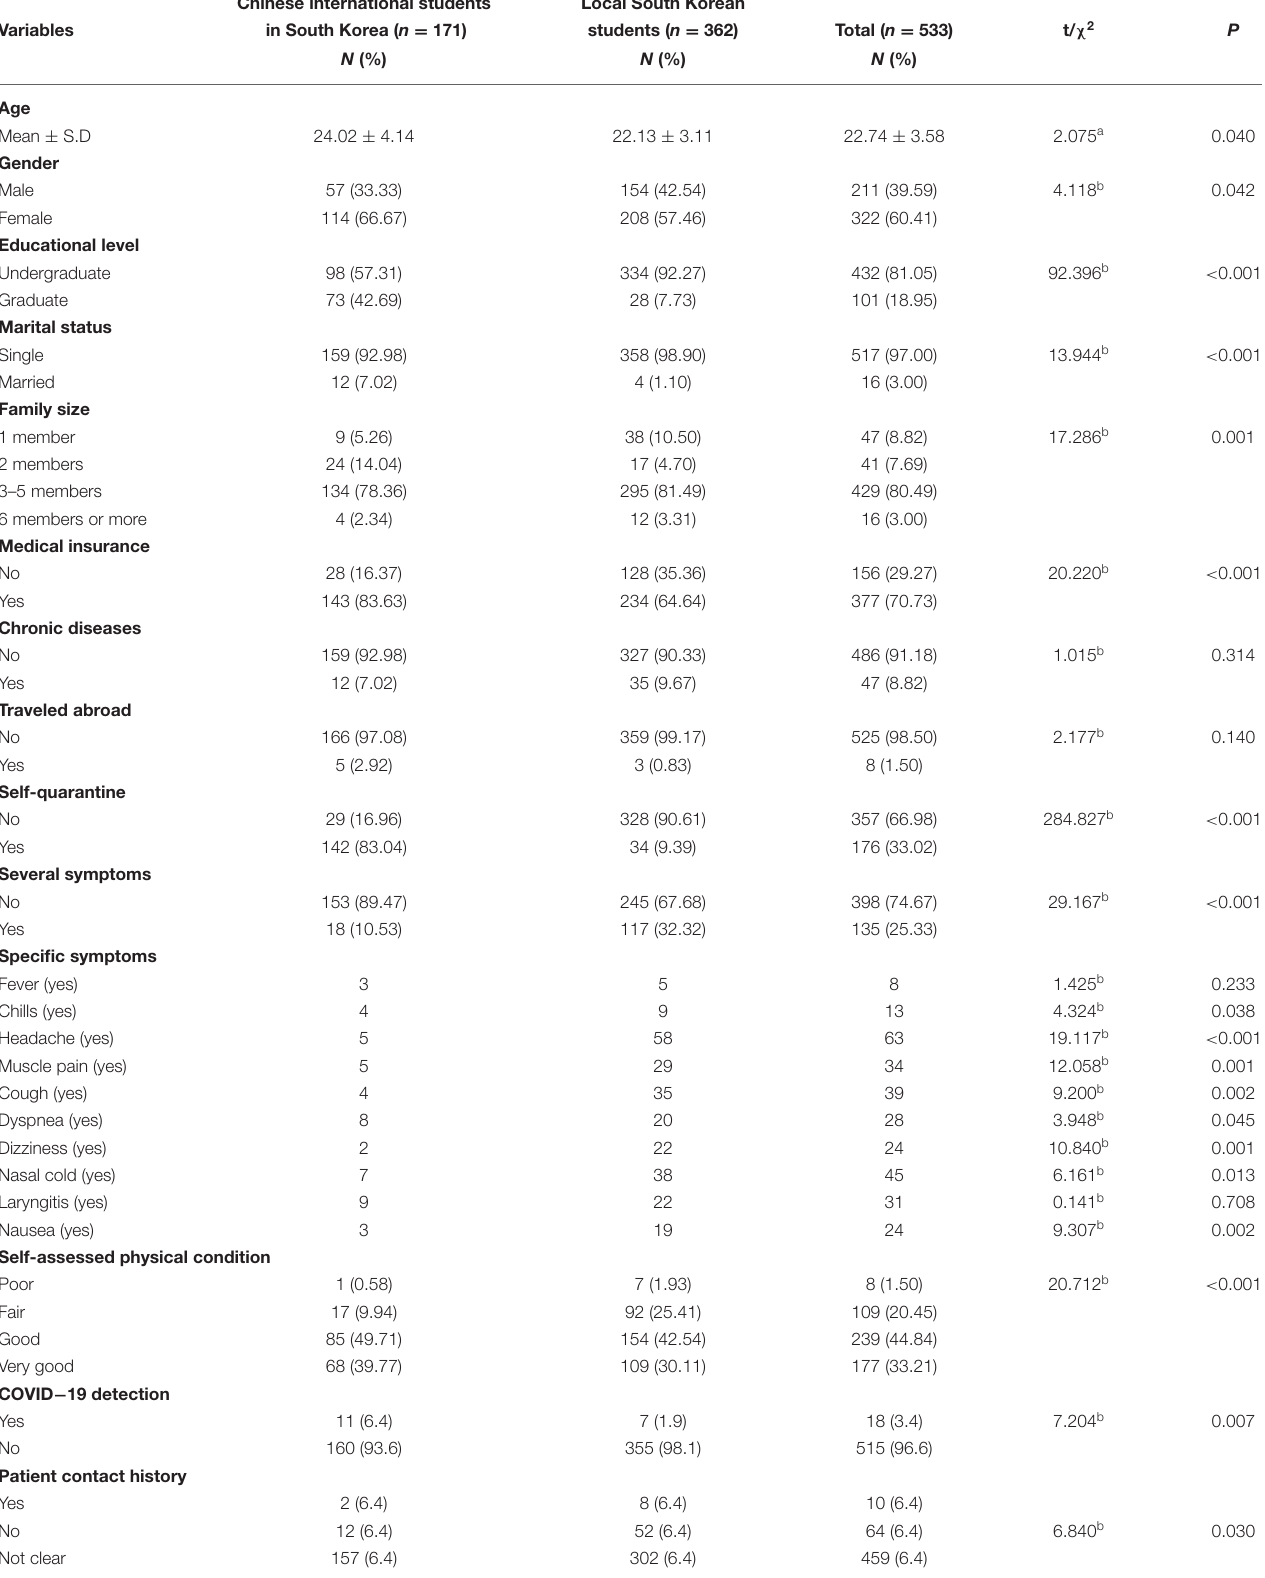
TABLE 1 | Demographics characteristics of the